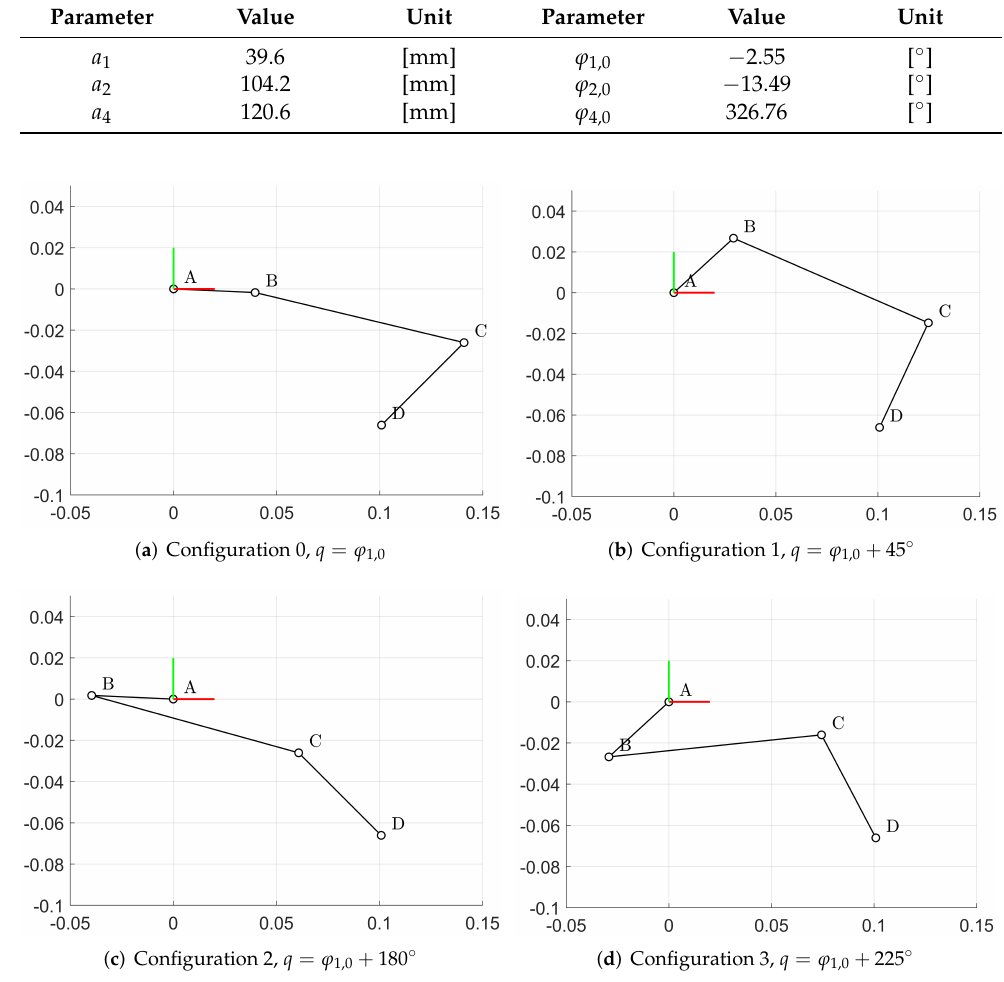
Figure 4. Configurations of the synthesis. ( a ) configuration 0; ( b – d ) configurations of the precision points. The same configuration numbers are reported in Figure